Question: Briefly state, in one sentence, what is plotted here.
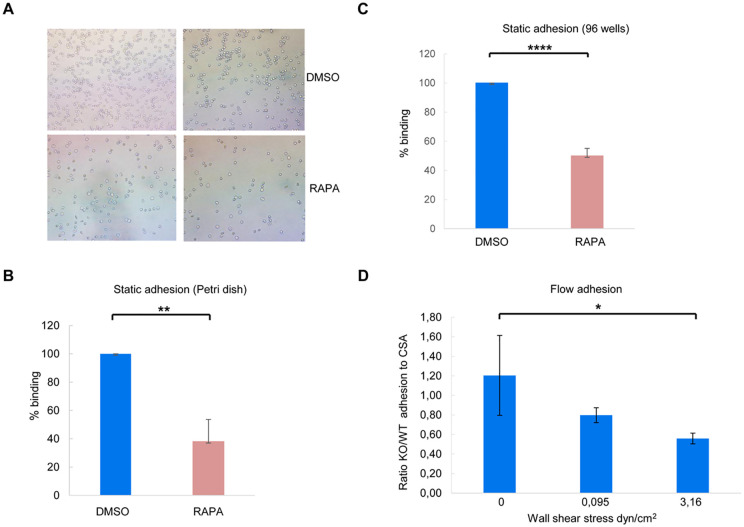
Answer: Deletion of FIKK1 after rapamycin induction affect IEs cytoadhesion. A and B. Static adhesion assay on plastic coated CSA. A. Typical pictures of bound DMSO- and RAPA-treated IEs conditions. B . Bound IEs were counted in 5 random fields. Results were expressed as percentage of binding (DMSO-treated cells correspond to 100% binding). Mean and standard deviation are indicated. (Statistics: n = 3, Unpaired t test **p = 0.002). C. Static adhesion assay in 96 wells plate. CSA-binding inhibition was assessed by relative quantification of DMSO and RAPA-treated IEs remaining bound to the plate surface after washes. The OD 650nm measures were obtained in triplicate; Means were used for calculation; Experimental data were analyzed using GraphPad Prism software. (Statistics: n = 3, ****p < 0.0001 Unpaired t test). D. Flow adhesion of RAPA/DMSO- treated IEs over CSA-coated slides at 0.0951 dyn/cm 2 and 3.1698 dyn/cm 2 wall shear stress; (Statistics: n = 6, *p = 0.02 Paired t test).